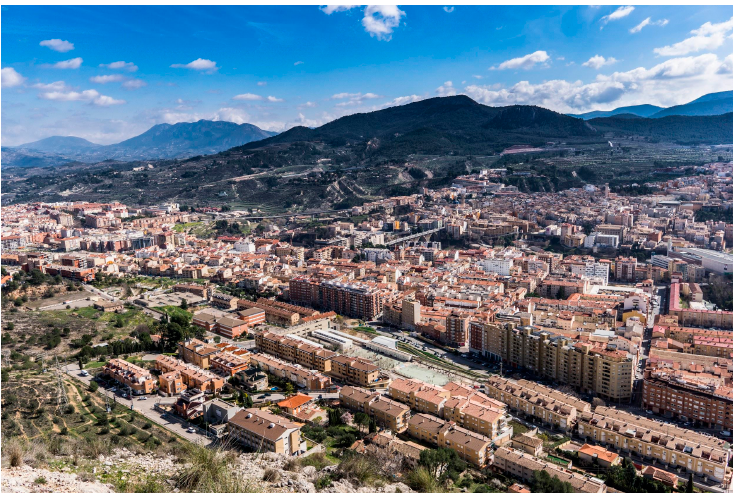
Figure 4. View of the city of Alcoi (Spain) (source: Jordi Miró).